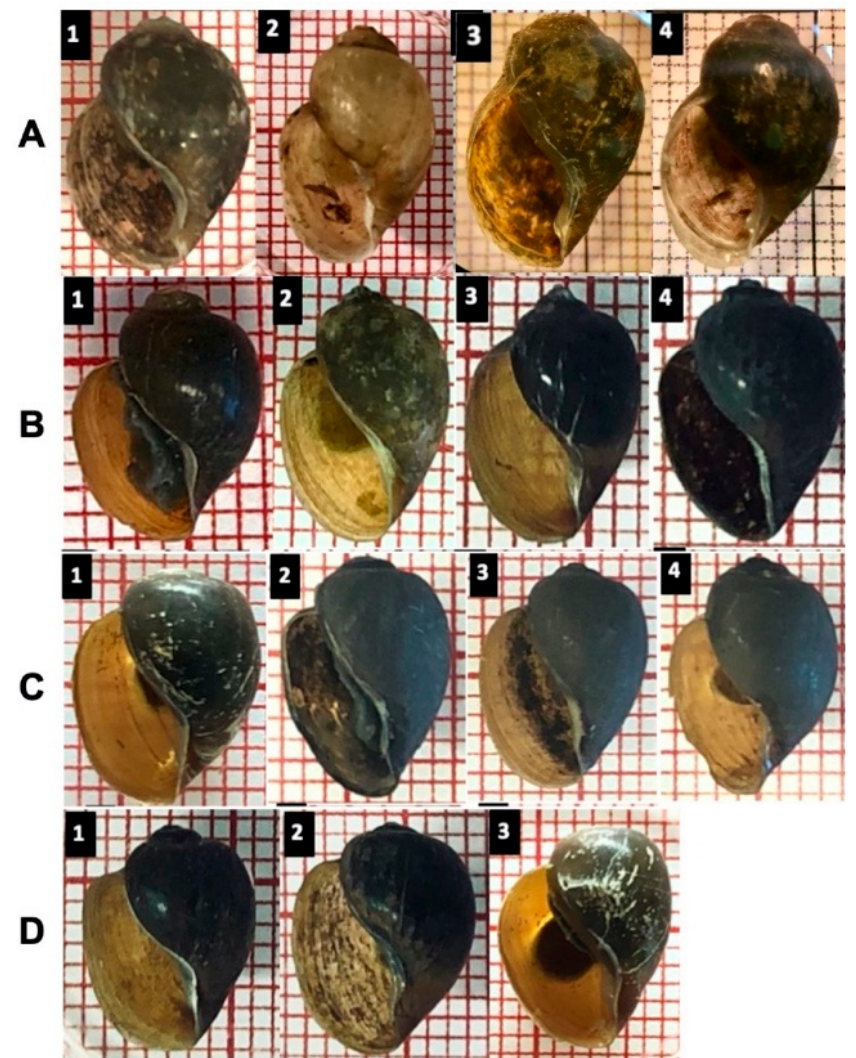
Figure 6. A visual comparison of selected shells indicates some subtle differences. Several shells were identified using both RFLP and sequence analysis. ( A ): B. globosus represents three different population habitats; A1–2: from Mangochi District, A3: from Blantyre, A4: Chikhwawa District ( B ): B. africanus , ( C ): B. angolensis , ( D ): Bulinus sp.